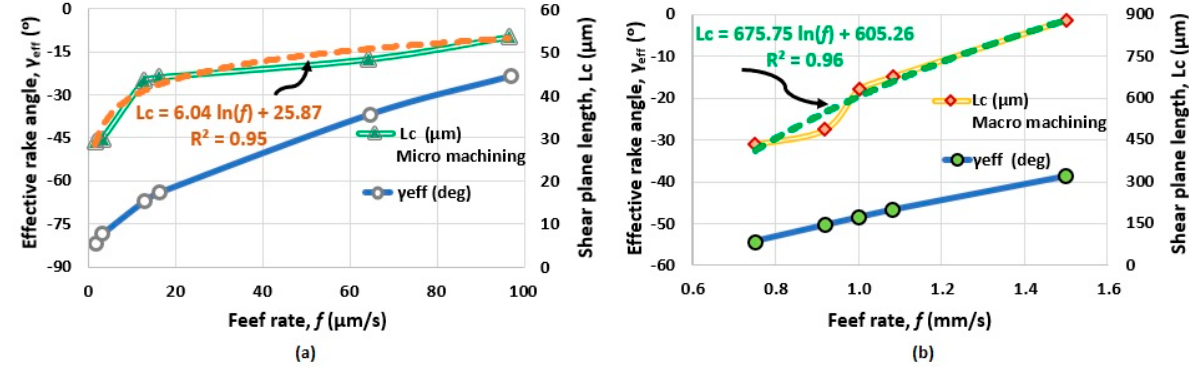
Figure 14. Variation of effective rake angle ( γ eff ) and length of the shear plane ( L c ) for ( a ) micro and ( b ) macro machining.